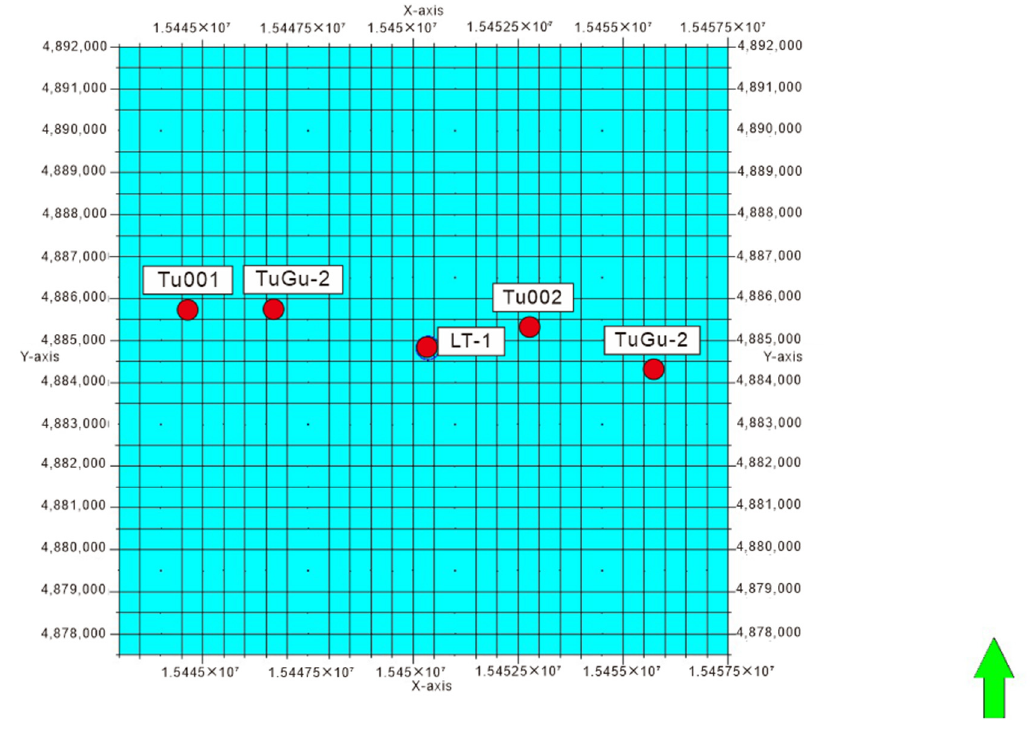
Figure 1. Planform of the TS block: target well and the relative position of existing wells. Table 1. Geological stratification and lithology description of well LT ‐ 1.